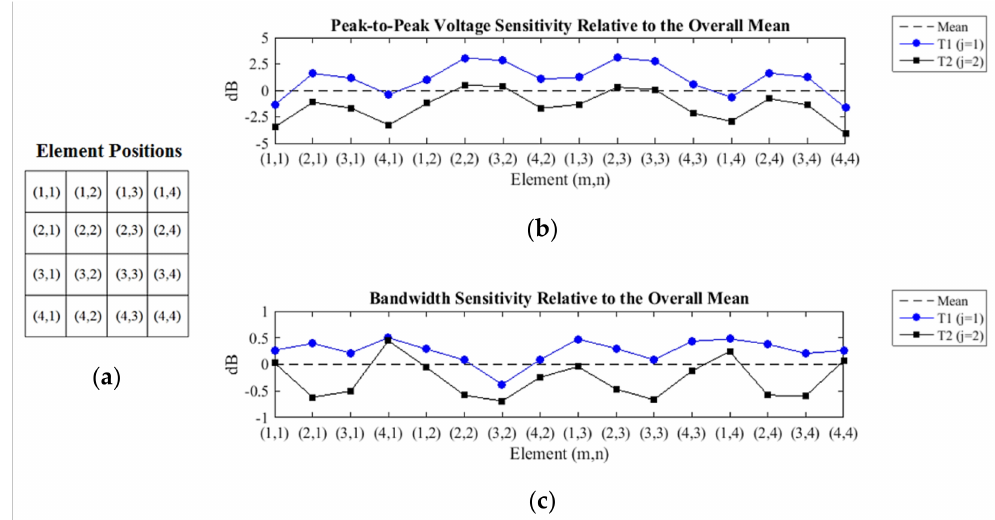
Figure 15. ( a ) The element positions are addressed as (m = line, n = column). ( b ) The transducer T1, j = 1, provides higher echo amplitudes and ( c ) broader bandwidth, being almost all of them above the overall mean, whereas the measurements of the transducer T2, j = 2, have shown worse results, mostly below the overall